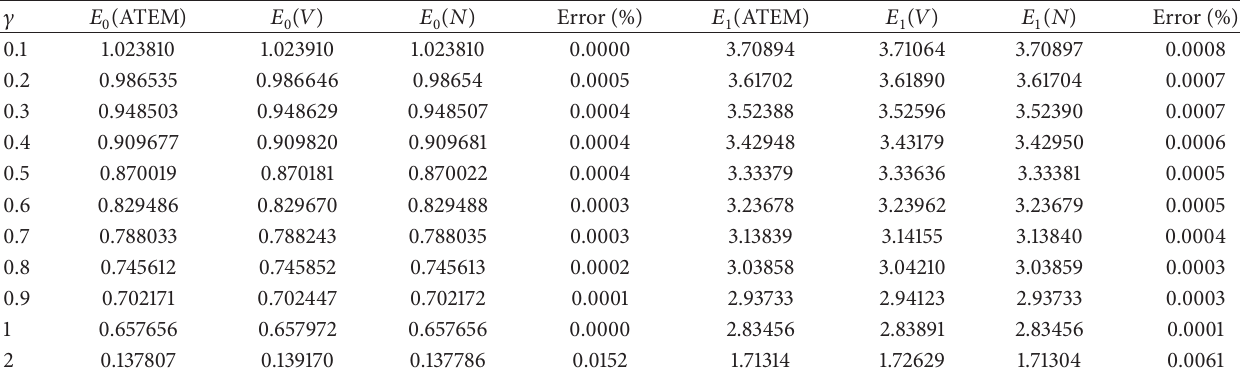
Table 2: Energy eigenvalues for the potential in (9) with different values of 𝛾 . 𝐸 0,1 (𝑉) and 𝐸 0,1 (𝑁) show the values obtained by variational supersymmetric method and numerical integration, respectively. The percent errors for ATEM are also shown in the fifth and ninth columns.